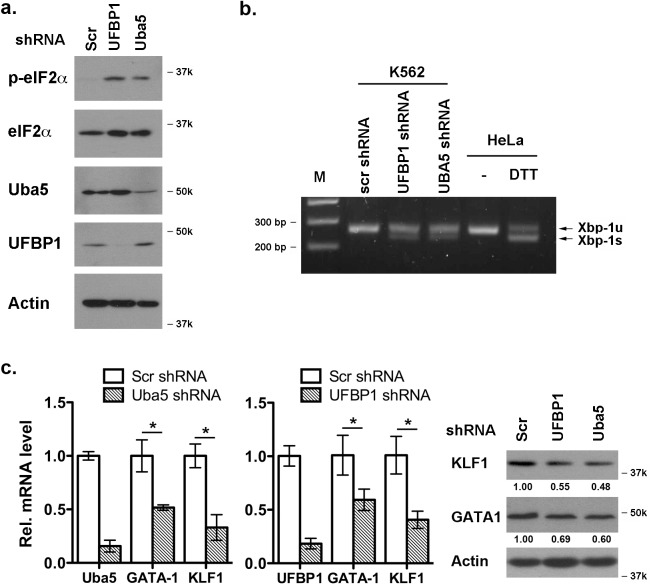
Depletion of Uba5 activates the UPR and suppresses expression of erythroid transcription factors in K562 cells.
a. Elevation of phosphorylation of eIF2α in Uba5- and UFBP1-depleted K562 cells. b. Xbp-1 mRNA splicing in Uba5- and UFBP1-depleted K562 cells. mRNA from DTT (dithiothreitol)-treated HeLa cells was used as a positive control. c. Under-expression of GATA-1 and Klf1 in Uba5- and UFBP1-depleted K562 cells. Total RNAs were purified from K562 cells and subject to quantitative RT-PCR analysis (normalized to β-actin gene). The data are presented as the relative level to the K562 cells treated with scrambled shRNA. * p < 0.01 (n = 3). Total cell lysates were subject to immunoblotting of indicated antibodies.